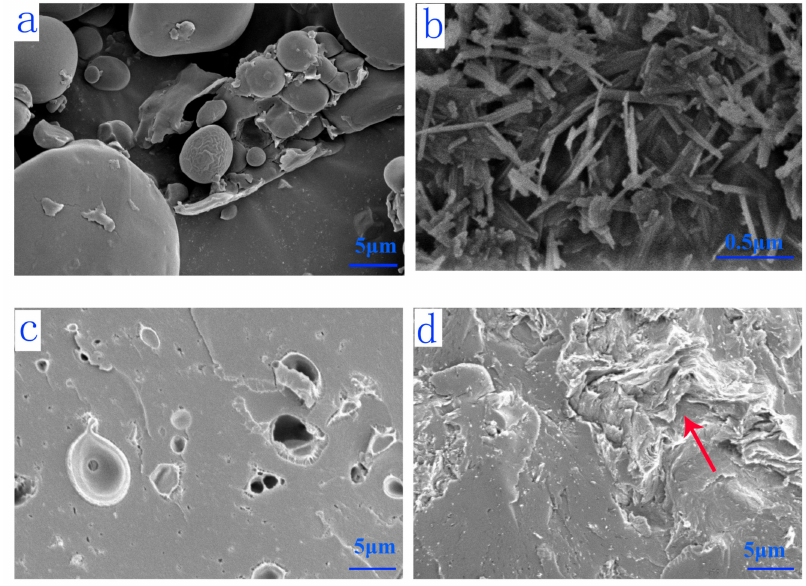
Figure 6. SEM images of WF ( a ), SEP ( b ), and cured UF resin with di ff erent fillers: Resin A1—100% WF + 0% SEP ( c ); Resin A5—80% SEP + 20% WF ( d